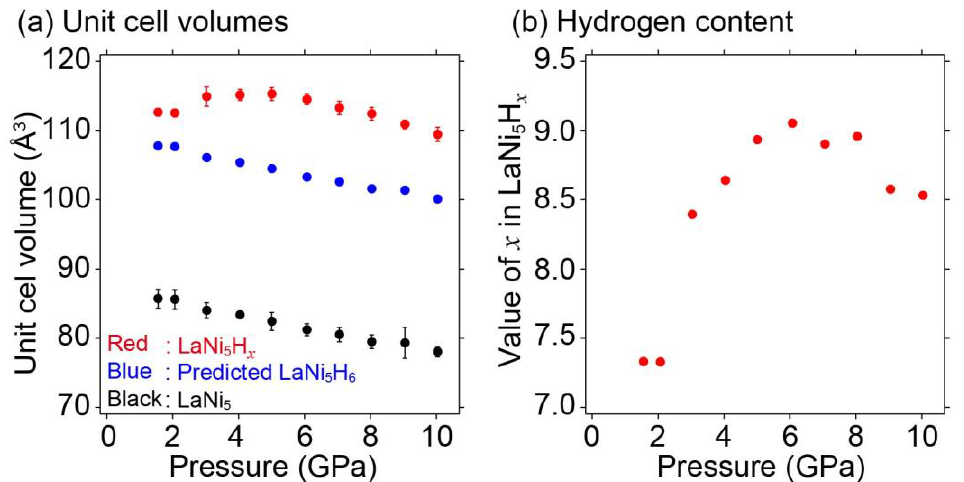
Figure 5. ( a ) Changes in the unit cell volume of LaNi 5 H x (LaNi 5 with BH 3 NH 3 ) predicted LaNi 5 H 6 and LaNi 5 without BH 3 NH 3 , and ( b ) estimated hydrogen content in LaNi 5 H x as a function of pres- sure.